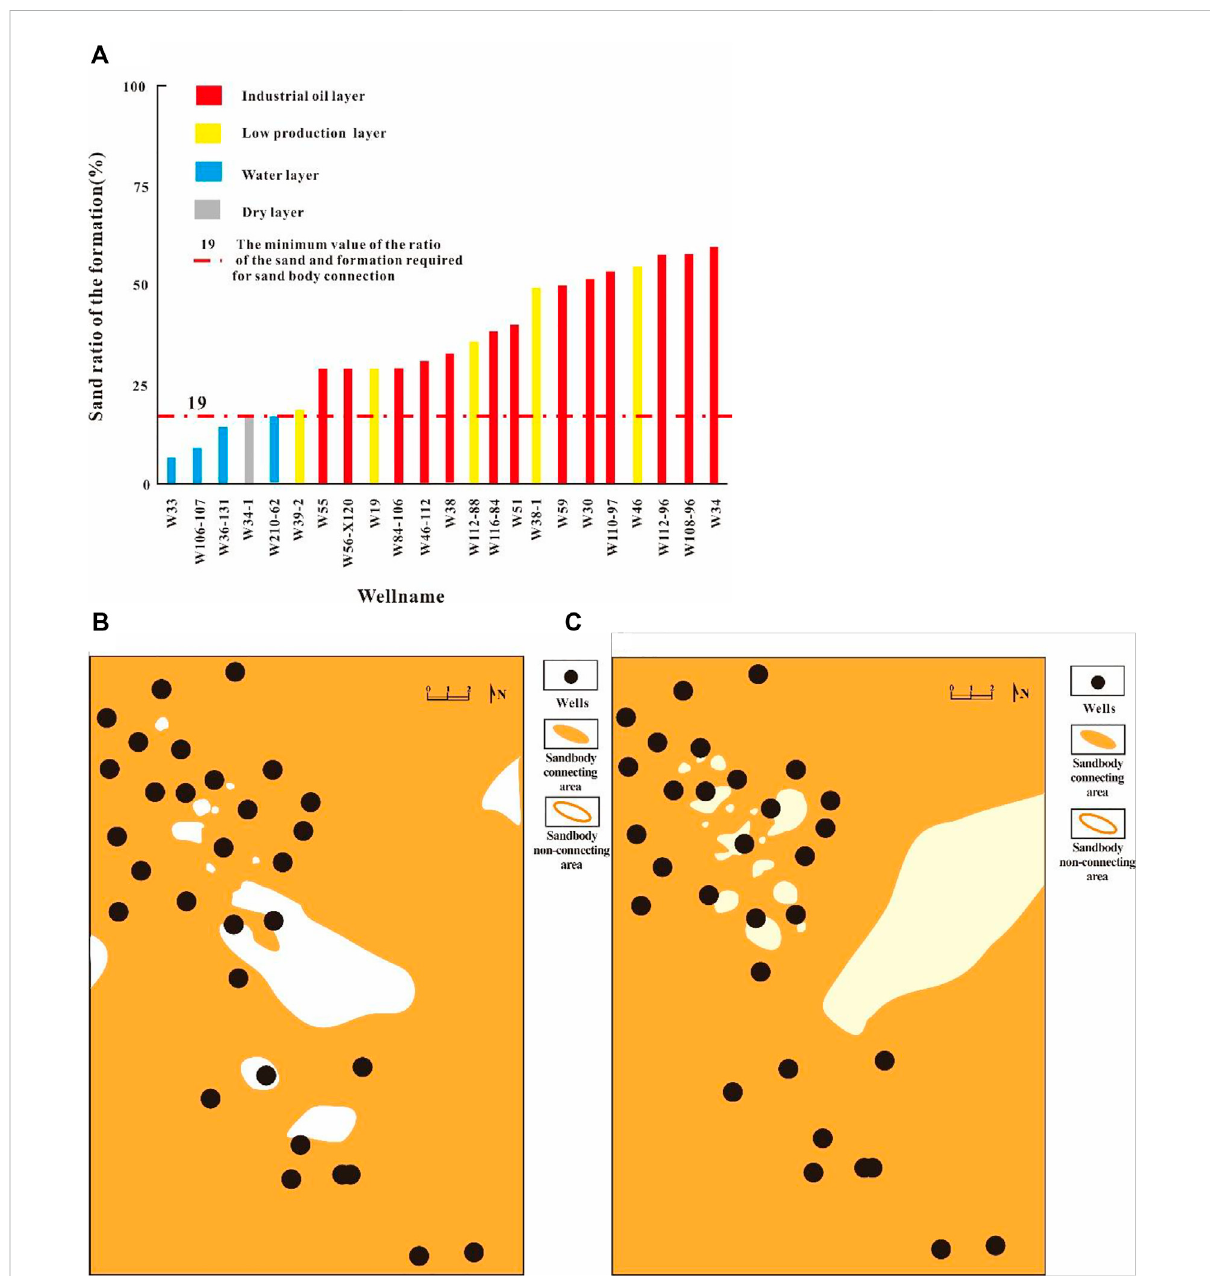
Determination of sand body connection distribution area for the fi rst member of the Nantun Formation (K 1 n 1 ) in the Wunan slope area; (A) The determination chart of the minimum value of the ratio of the sand and formation required for sand body connecting distribution in the Nantun Formation; (B) The sand body connecting distribution in oil formation Ⅰ of K 1 n 1 ; (C) The sand body connecting distribution in oil formation Ⅱ of K 1 n